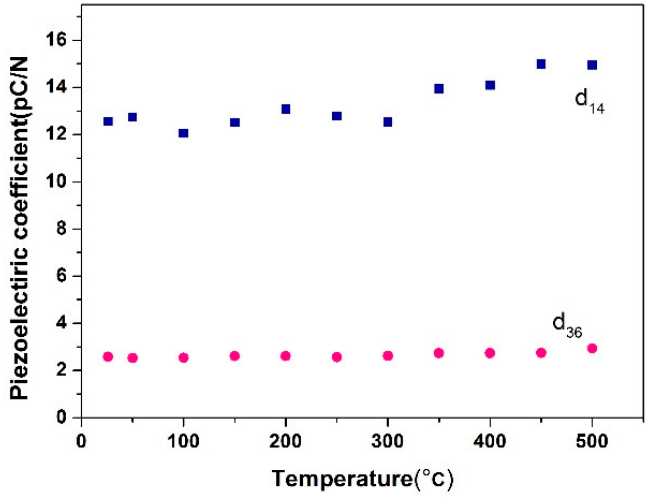
Figure 7. Temperature dependent piezoelectric coefficient of CYAM crystal. Figure 7 Temperature dependent piezoelectric coefficient of CYAM crystal. Figure 7 Temperature dependent piezoelectric coefficient of CYAM crystal.